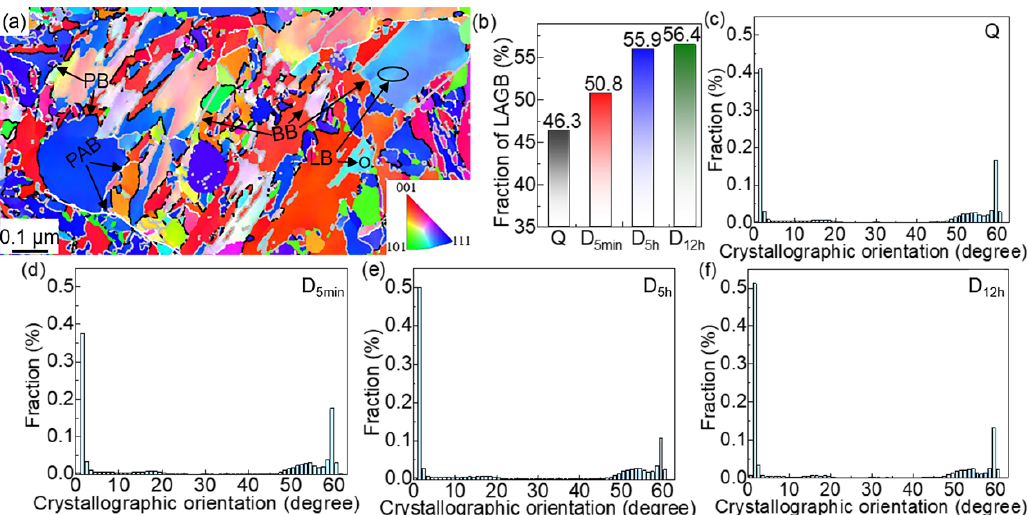
Figure 10. ( a ) The distribution of the martensitic boundary details, the ( b ) proportions, and ( c – f ) the distribution of LAGBs.